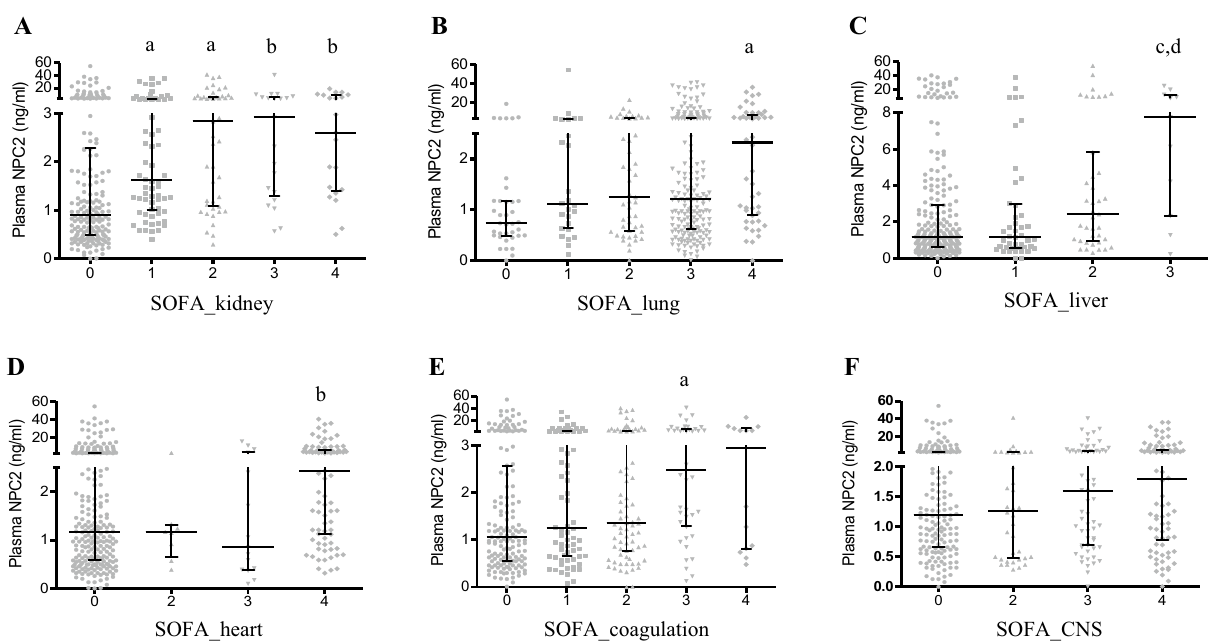
Figure 3. The concentrations of plasma Niemann–Pick disease type C2 protein (NPC2) in sepsis patients with dysfunction of different organ systems. The concentration of plasma NPC2 was determined by ELISA. The degrees of organ dysfunction are indicated by SOFA scores. Plasma NPC2 concentration was plotted against the SOFA scores of the kidney ( A ), lung ( B ), liver ( C ), heart ( D ), coagulation ( E ) and central nervous system ( F ). Kruskal–Wallis ANOVA test followed by the Dunn’s test was used. p values reflect a two-tailed testing. a: p < 0.01 versus the “SOFA = 0” group; b: p < 0.001 versus the “SOFA = 0” group; c: p < 0.05 versus the “SOFA = 0” group; d: p < 0.05 versus the “SOFA = 1”